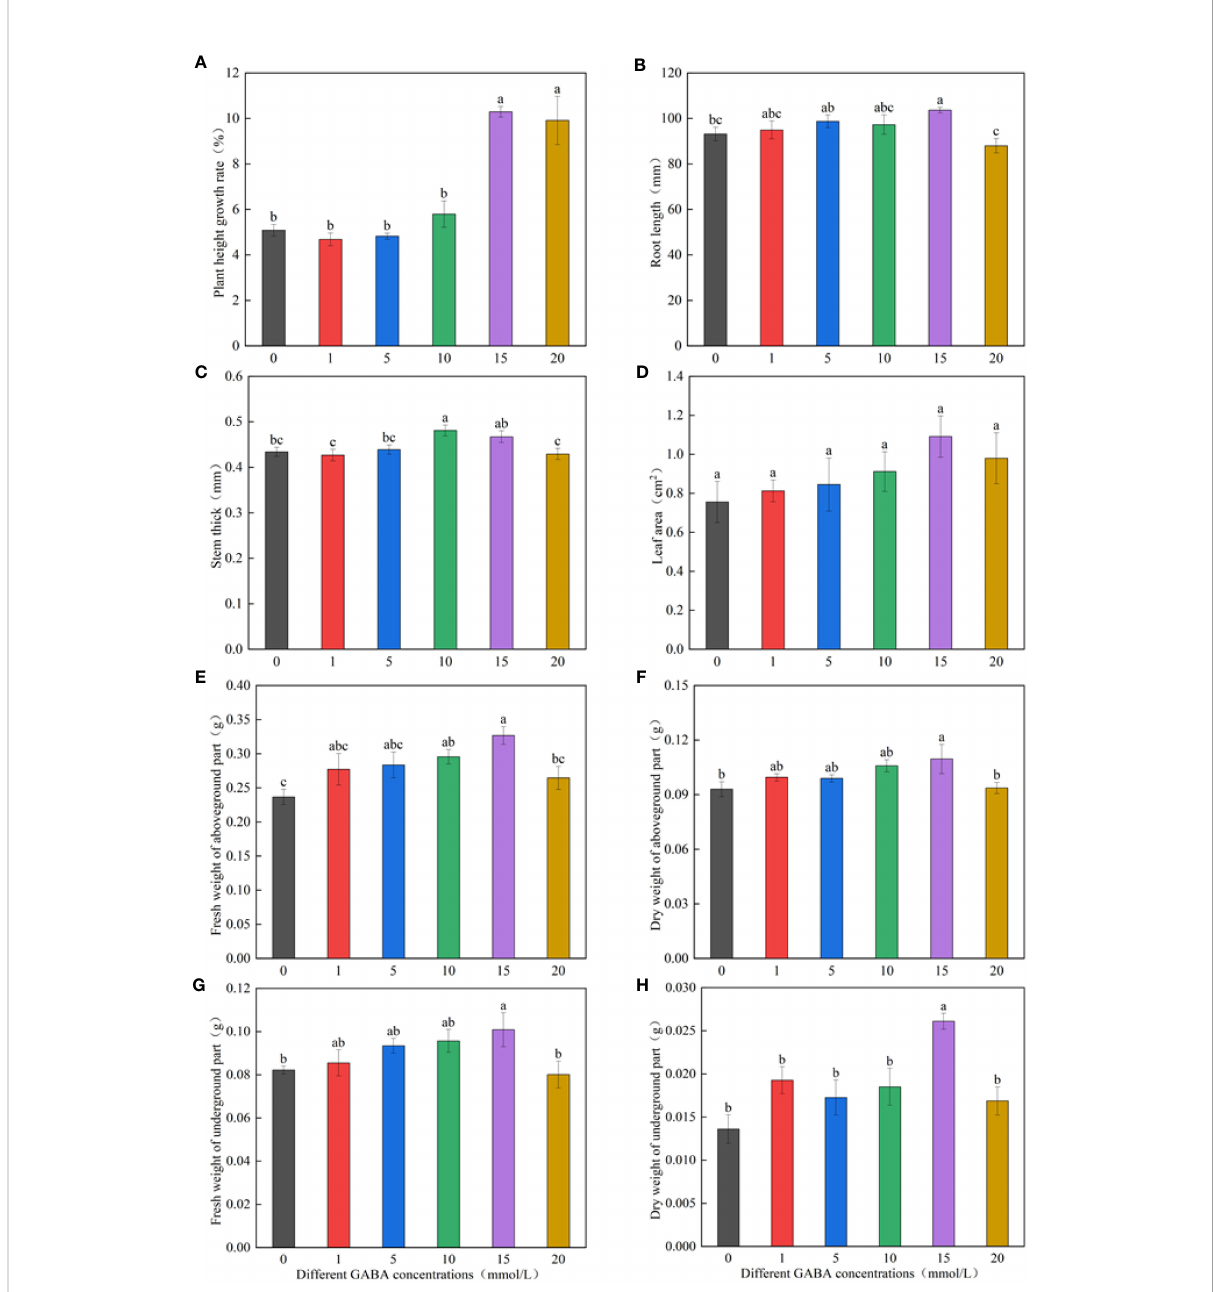
FIGURE 1 Effects of different GABA concentrations on seedling growth indexes. The growth temperature of seedlings is low-temperature in Figure (A-H) . Different lowercase letters indicate signi fi cant differences between treatments ( P <